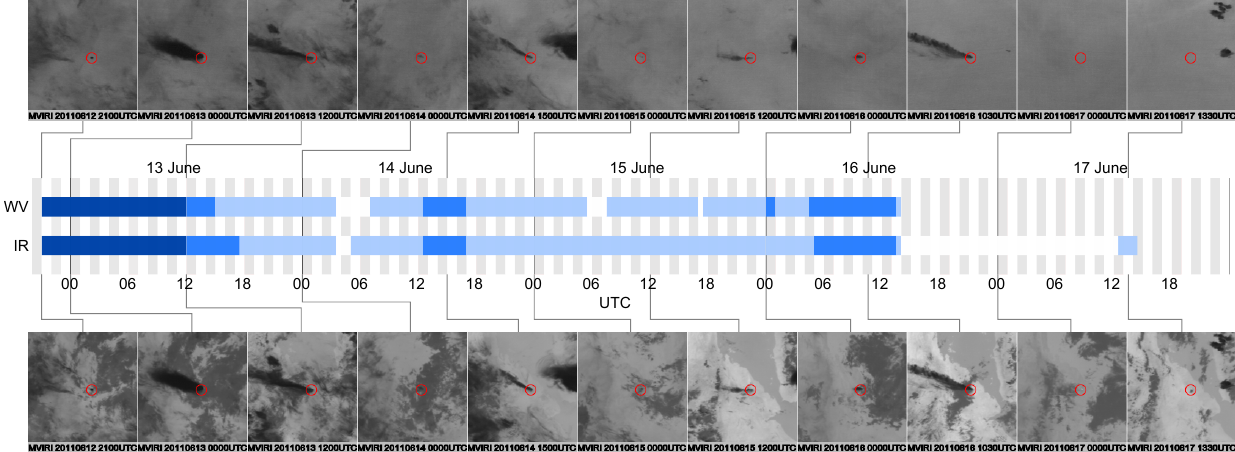
Figure 9. Time line of the 2011 Nabro eruption based on MVIRI IR and WV measurements from Meteosat-7 (IODC). The satellite images were used to roughly estimate the strength of the volcanic activity (white is none, light blue is low level, blue is medium level, dark blue is high level).